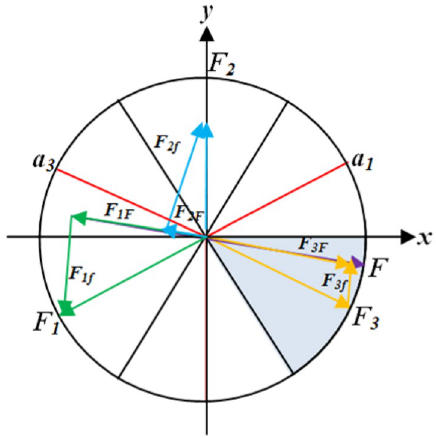
’ > 330 or α ’ ≤ 30 K K